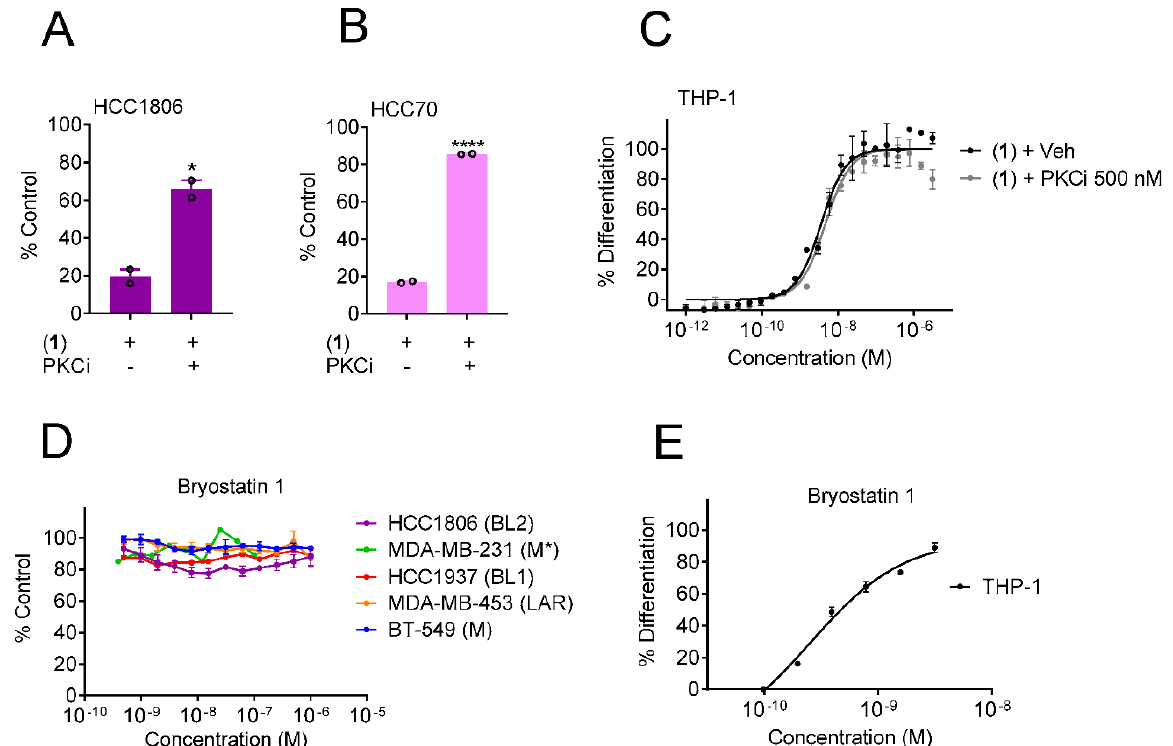
Figure 4. BL2 subtype selectivity of yuanhuacine is dependent on PKC activity. Growth of ( A ) HCC1806 or ( B ) HCC70 cells pretreated with 500 nM of Ro-31-8220 (PKCi) for 4 h and then treated with a concentration of 1 that results in 80% growth inhibition on its own (50 or 200 nM, respectively) for 48 h. Significance was determined by unpaired t -test. * p < 0.05, **** p < 0.0001. ( C ) Concentration response curve of THP-1 differentiation when cells were pretreated with 500 nM of Ro-31-8220 (PKCi) for 4 h and then treated with 1 for 24 h. ( D ) Concentration response curves of the growth of cells representing diverse TNBC molecular subtypes when treated with bryostatin 1. ( E ) Concentration response curve of THP-1 differentiation when cells were treated with bryostatin 1. * The MDA-MB-231 cell line was originally classified as the MSL subtype and regrouped into the consolidated M subtype due to its mesenchymal phenotype. Error bars indicate the SEM of 2–4 biological